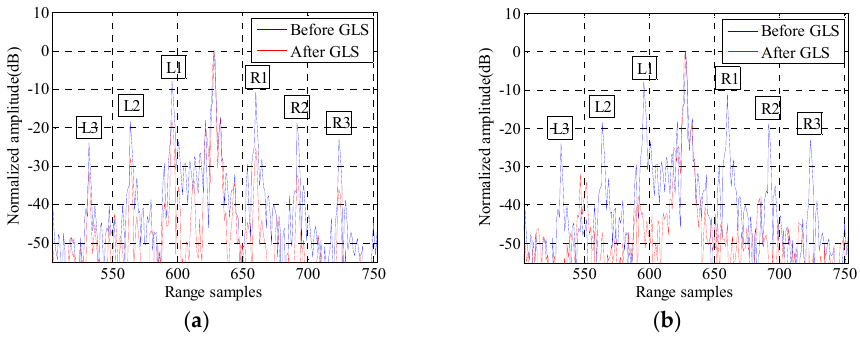
Figure 4. The HRRPs of target 2 before and after GLS: ( a ) GLS by GLPP; and ( b ) GLS by the proposed method. Table 2. Magnitudes of grating lobes before and after GLS.